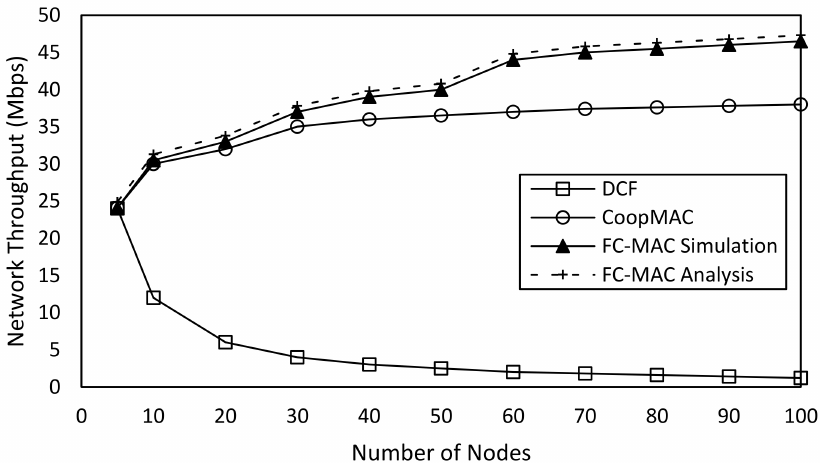
Figure 3. Network Throughput.